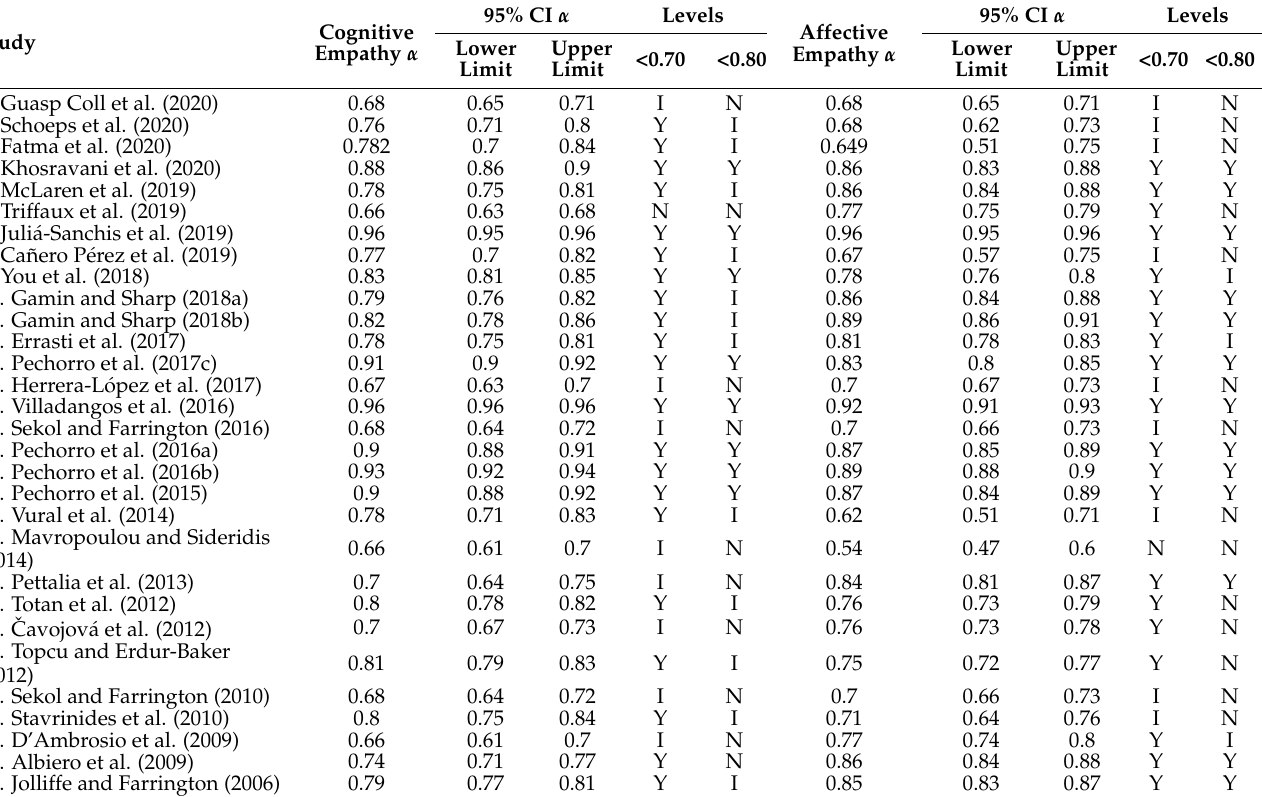
Table A2. Characteristics of the reliability levels of the articles included in the